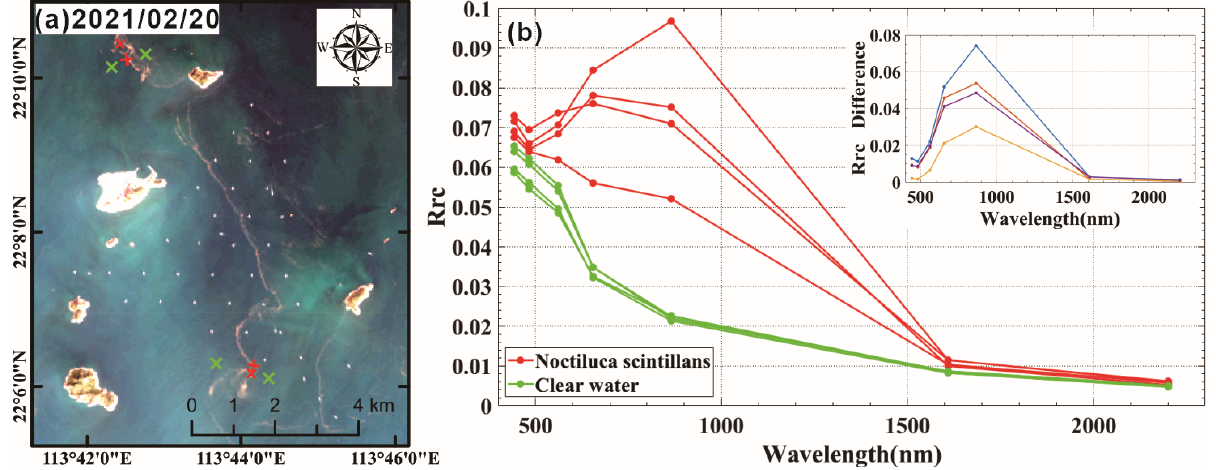
Figure 7. ( a ) Red Noctiluca Scintillans bloom in the Pearl River Estuary; ( b ) spectral curves of selected Red Noctiluca Scintillans and nearby water pixels marked as red and green crosses in panel a, respectively. The inset shows the Rrc difference between Red Noctiluca Scintillans and nearby water. Slick features partially blocked by small cloud (scattered cloud) or other objects would be connected through visual interpretation in the delineation process (e.g., in Fig ‐ ure 2). If the slick feature was under complete cloud cover, it would not be detected through the OLI image. Or, if a large portion of the slicks was under cloud cover, such slicks would not be delineated for areal analysis. To be conservative, all delineated slicks with an area <0.2 km 2 (corresponding to slicks ~1 km in length and ~200 m in width, not including the detached ones from a major slick, where they were defined as one slick in this study) were excluded from the dataset.